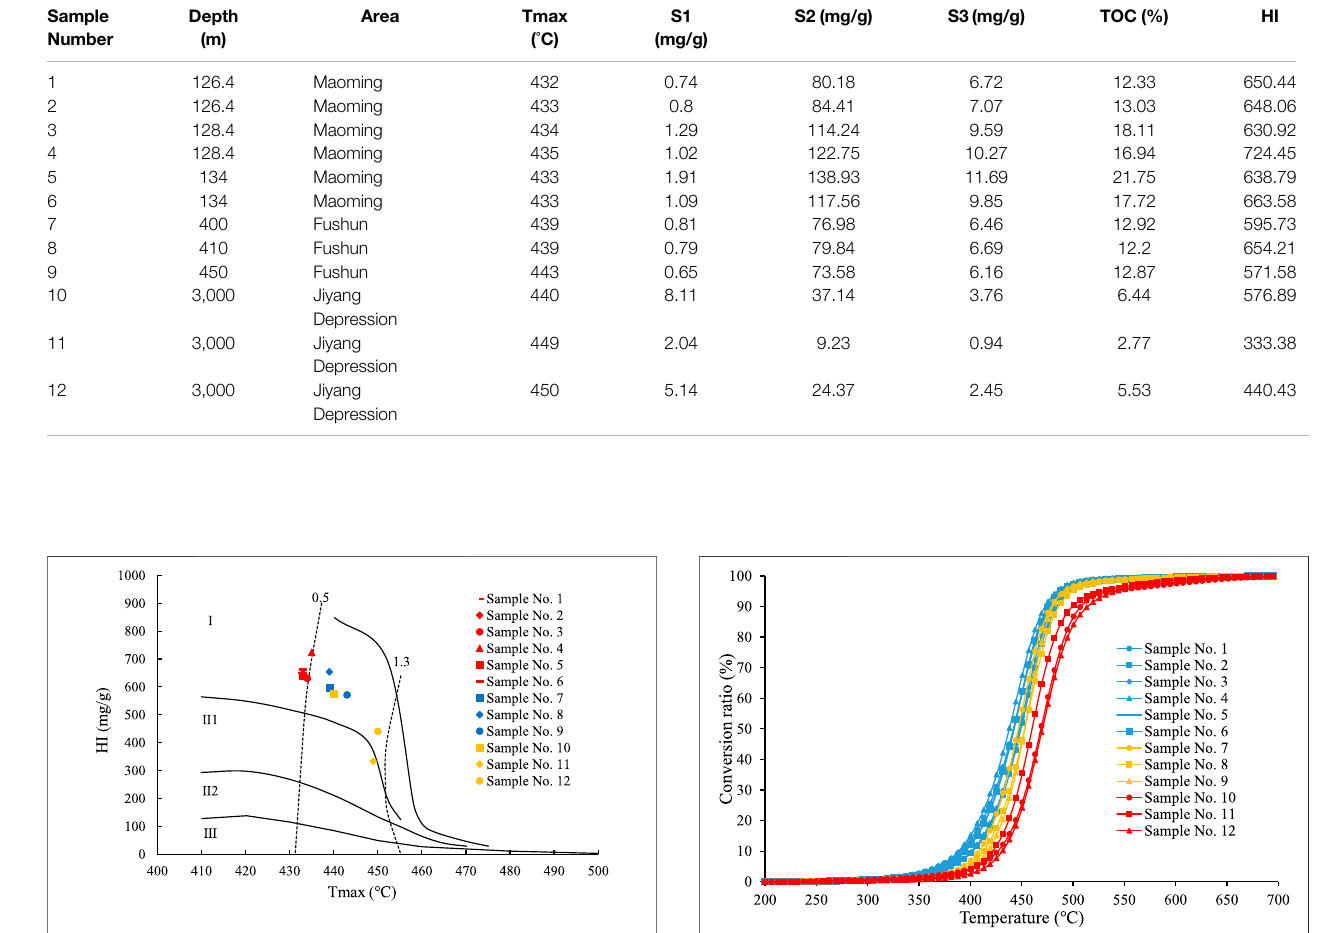
TABLE 1 | The initial geochemical parameters of the samples.